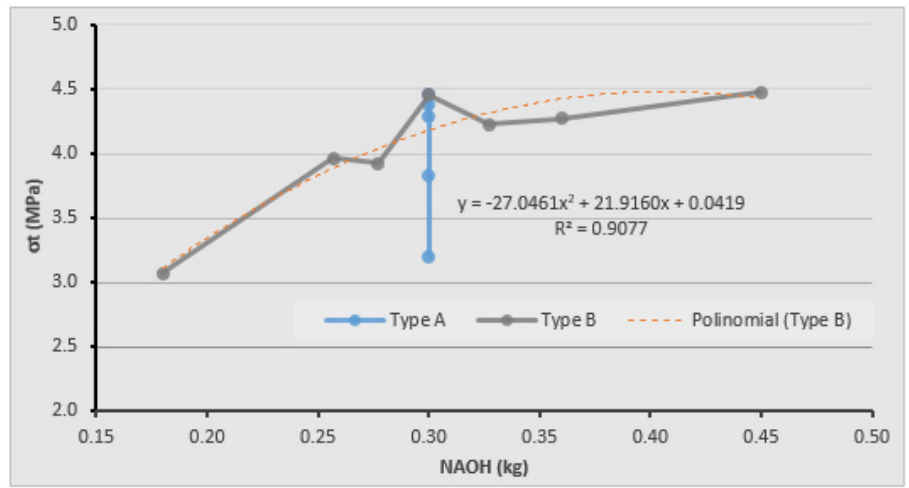
Figure 7. Influence of sodium hydroxide (NaOH) on the tensile strength.